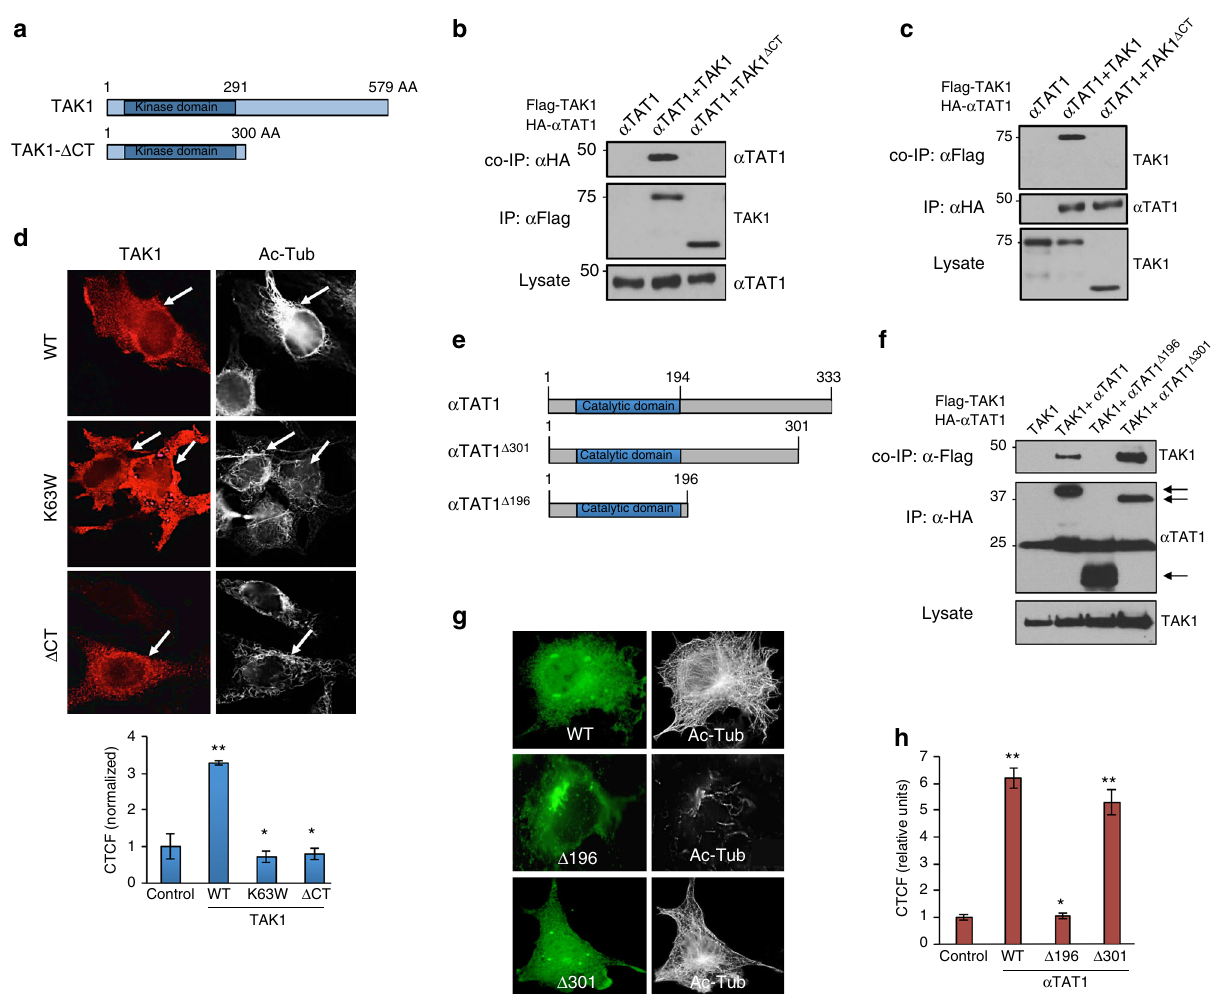
Fig. 3 Structural determinants of TAK1 required for α TAT1 binding. a Schematic representation of TAK1 WT and C-terminal truncated mutant TAK1- Δ CT. b COS-7 cells expressing HA- α TAT1 WT, Flag-TAK1, or Flag- TAK1- Δ CT were immunoprecipitated with Flag antibody. c COS-7 cells expressing HA- α TAT1 WT, Flag-TAK1, or Flag-TAK1- Δ CT were immunoprecipitated with α HA antibody. d COS-7 cells expressing Flag-TAK1 WT, Flag-TAK1 KD (K63W), and Flag-TAK1- Δ CT were fi xed and imaged for Flag (left panel) and Acetyl-tubulin (right panel) immuno fl uorescence co-staining. CTCF was quanti fi ed using Image J, at least 30 cells were quanti fi ed per condition. The images are representative of three independent experiments, n = 3. Error bars represent SEM and type 2 t -test analysis show relative to control: *not signi fi cant; ** p < 0.001. e Schematic representation of α TAT1-WT and truncation mutants α TAT1- Δ 301, α TAT1- Δ 196. f COS-7 cells expressing Flag-TAK1 WT, HA- α TAT1 WT, HA- α TAT1- Δ 196, or HA- α TAT1- Δ 301 were immunoprecipitated with α -HA antibody. g , h COS-7 cells expressing HA- α TAT1 WT, HA- α TAT1- Δ 196, or HA- α TAT1- Δ 301 were fi xed and imaged for α -HA (left panel) and Acetyl- tubulin (right panel) immuno fl uorescence co-staining. CTCF was quanti fi ed using Image J, at least 30 cells were quanti fi ed per condition. The images are representative of three independent experiments, n = 3. Error bars represent SEM and type 2 t -test analysis show relative to control: *not signi fi cant; ** p <